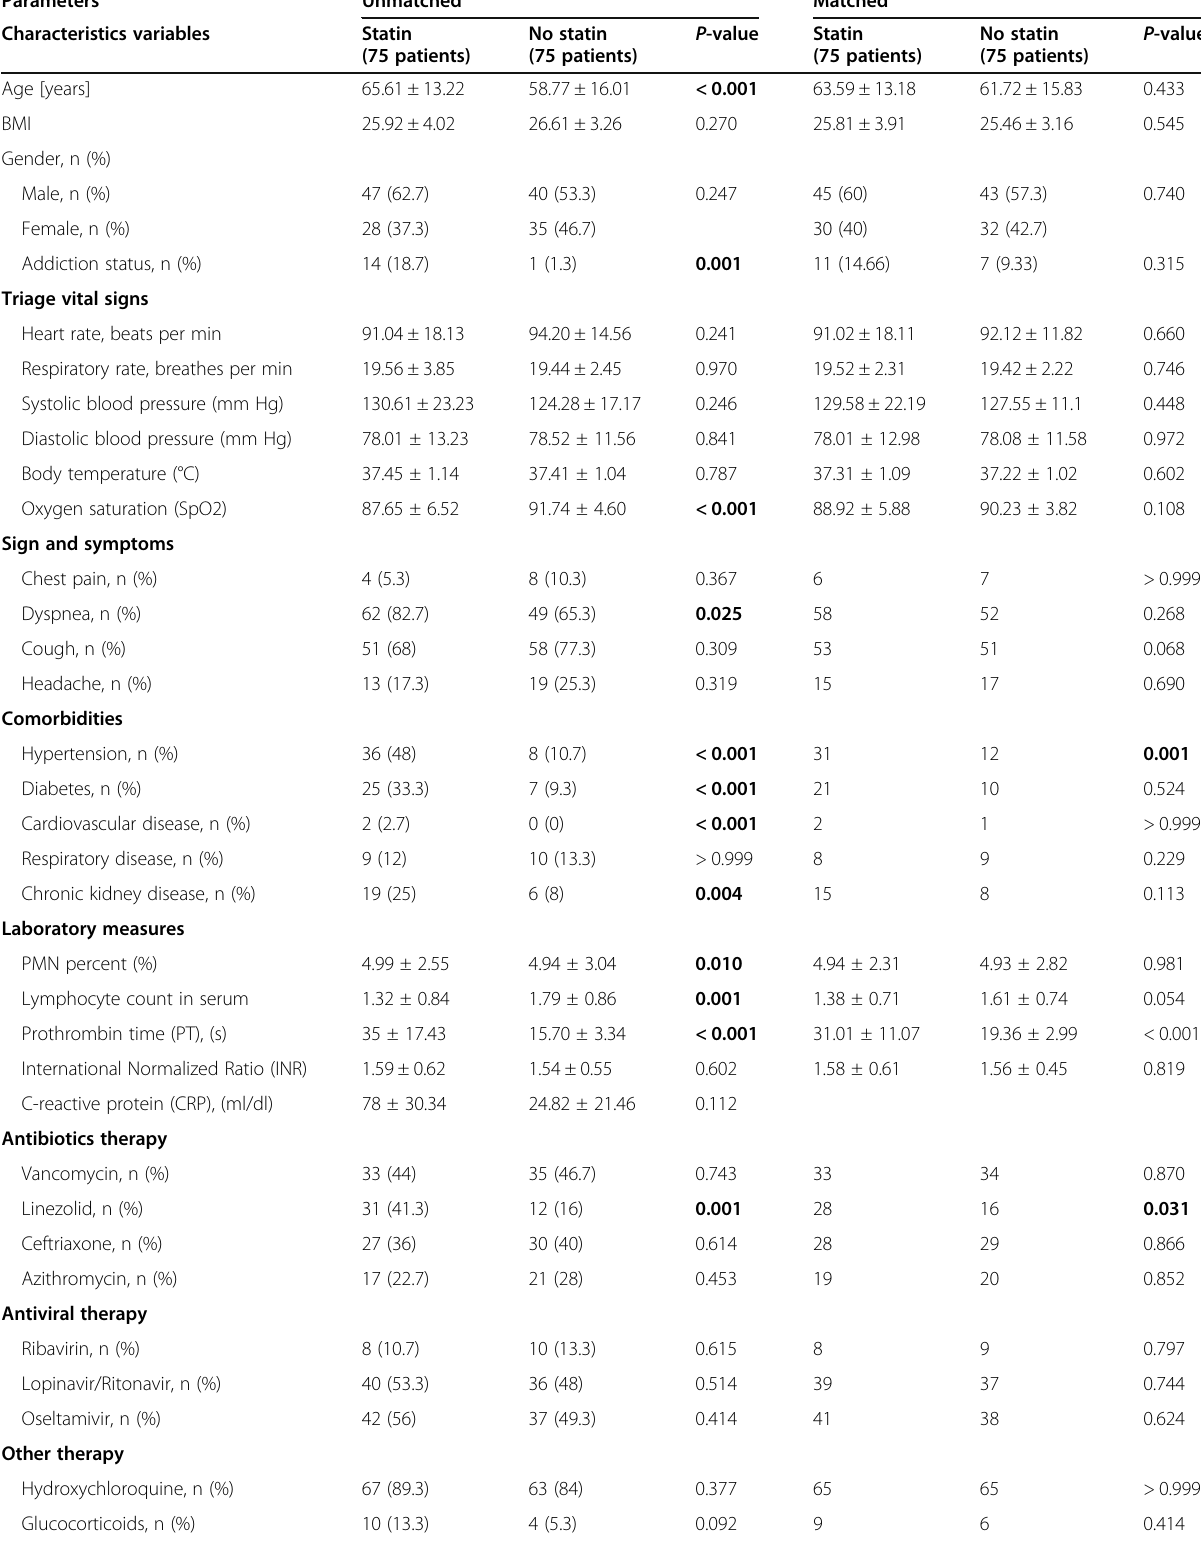
Table 1 Characteristics and comparison of patient groups (statin vs no statin), before and after propensity score matching